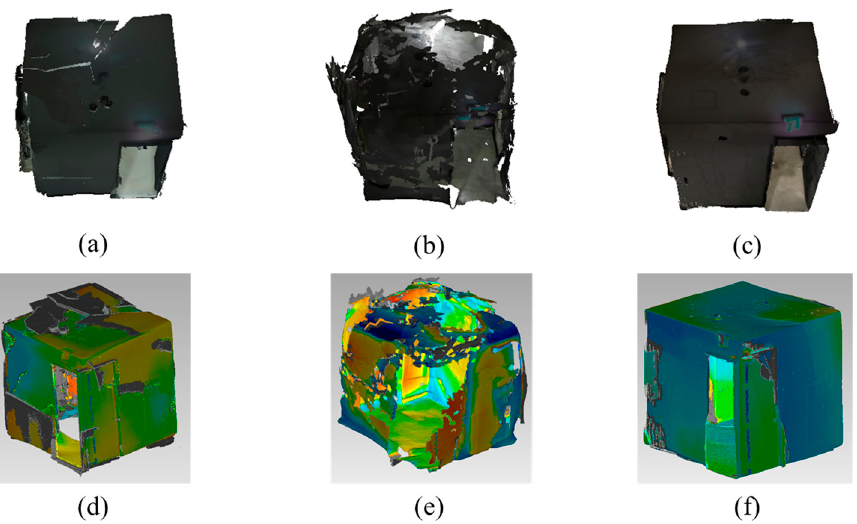
Figure 8. Reconstructed result and error analysis of indoor scene with various methods: Recon- structed result with ( a ) ToF camera; ( b ) stereo camera; ( c ) proposed method; error analysis of ( d ) ToF camera; ( e ) stereo camera; ( f ) proposed method.